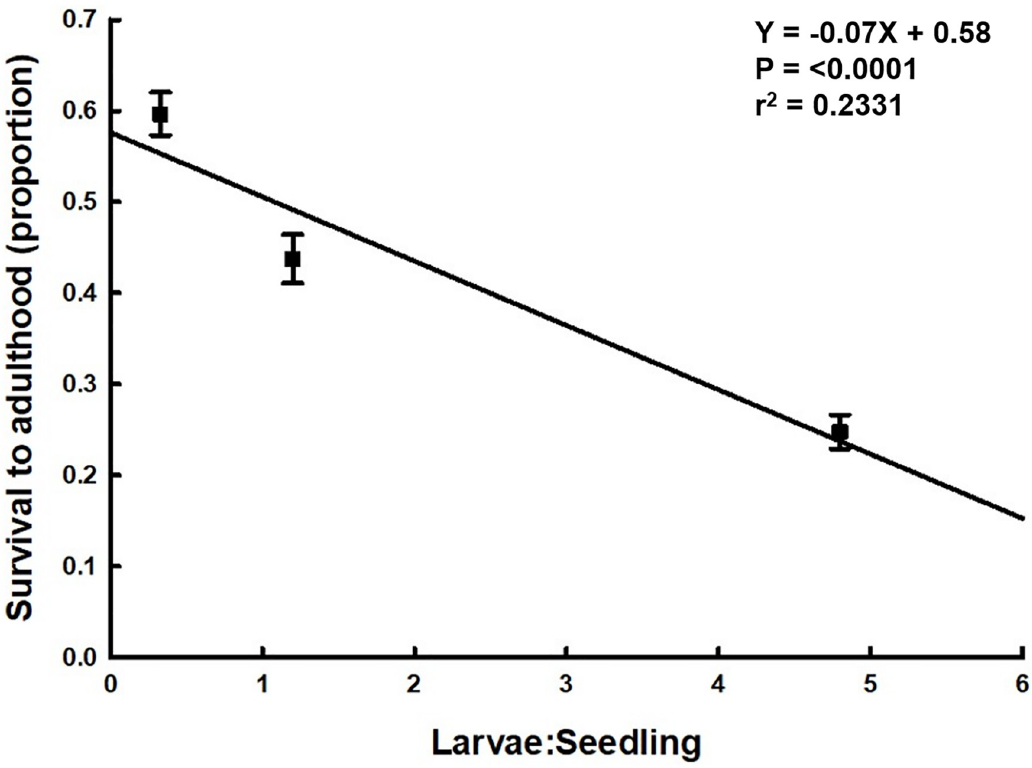
Fig 1. Survival to adulthood of western corn rootworm males and females reared at different larval densities. Points represent sample means, and error bars indicate SEM. Linear regression analysis was conducted with raw data. Linear regression of proportion adult emergence (Y) on larval density (X): df = 1, 370, Y = -0.07X + 0.58, t = -10.61, P < 0.0001, r 2 = 0.2331.